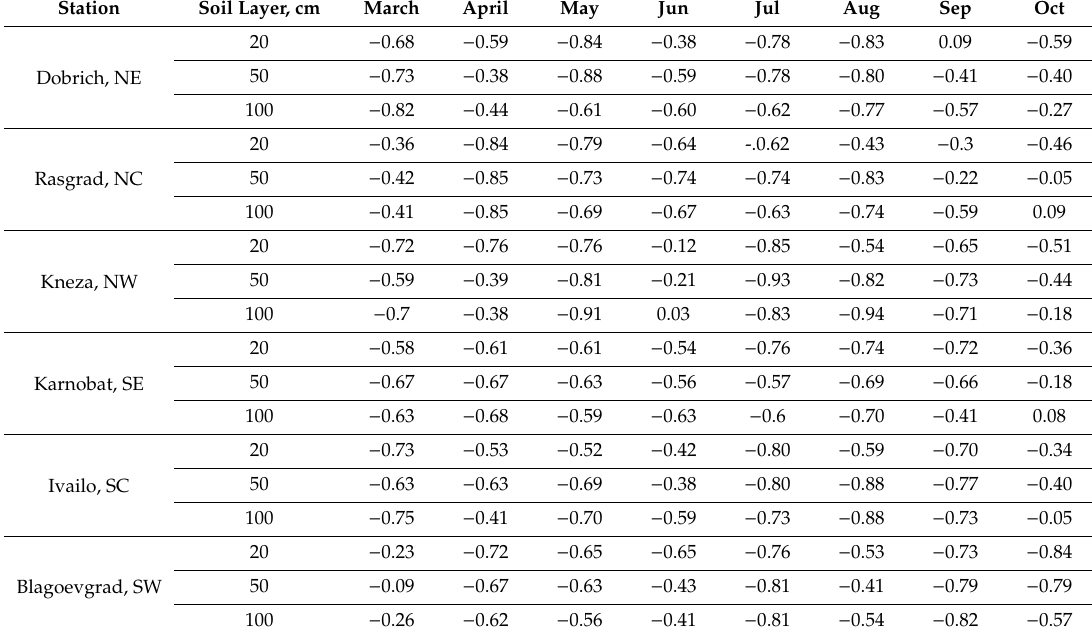
Table 3. Pearson’s correlation coe ffi cients between the SMAI and LST anomalies for the Nomenclature of Territorial Units for Statistics (NUTS) regions of Bulgaria. NE, northeastern; NC, northcentral; NW, northwest; SE, southeastern; SC, southcentral; SW, southwest. Station Soil Layer, cm March April